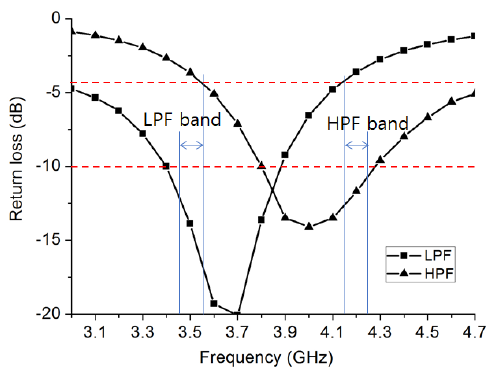
Figure 5. Matching results of the T-junction matching circuit.